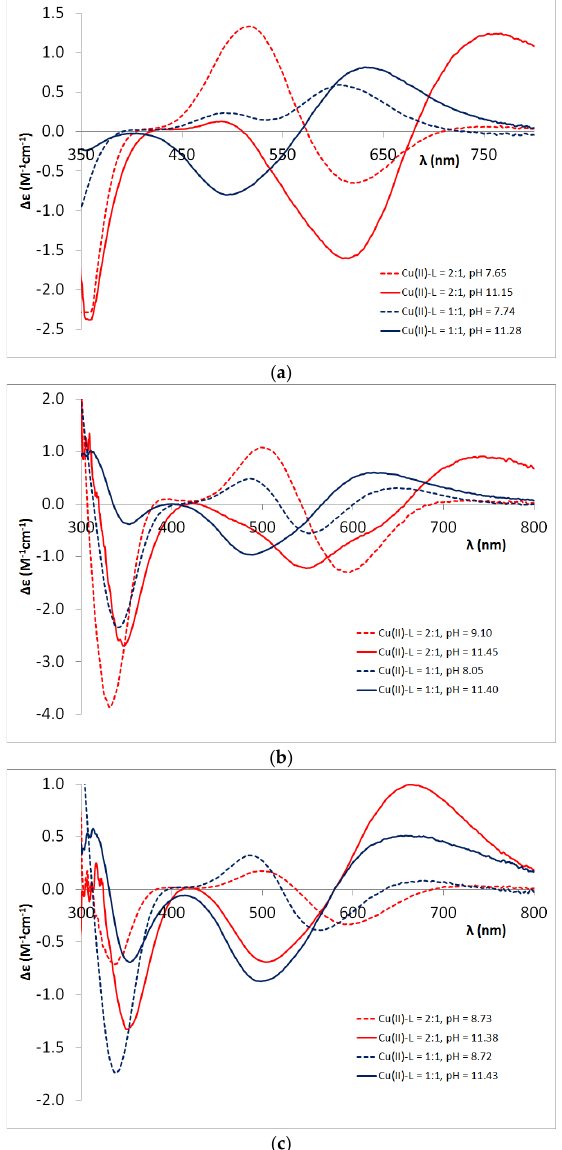
Figure A3. CD spectra registered in the solution containing copper(II) ion and ligand 2:1 (blue) and 1:1 (red) ratio at different pH; L = Ac-HDHAH-NH 2 ( a ), L = Ac-HFHAH-NH 2 ( b ), L = Ac-HKHAH-NH 2 ( c ).